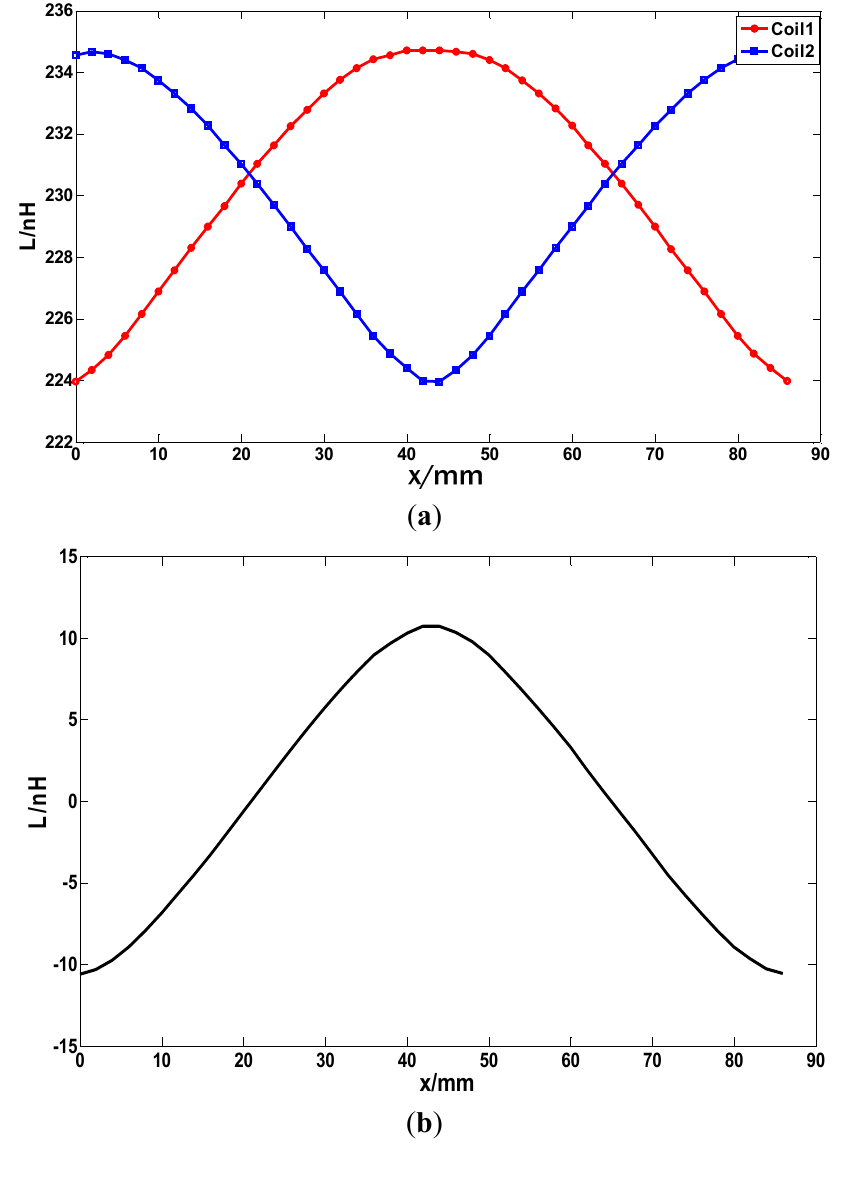
Figure 16. ( a ) Relative position and Inductance curve of coil 1 and 2; and ( b ) Inductance difference and relative position